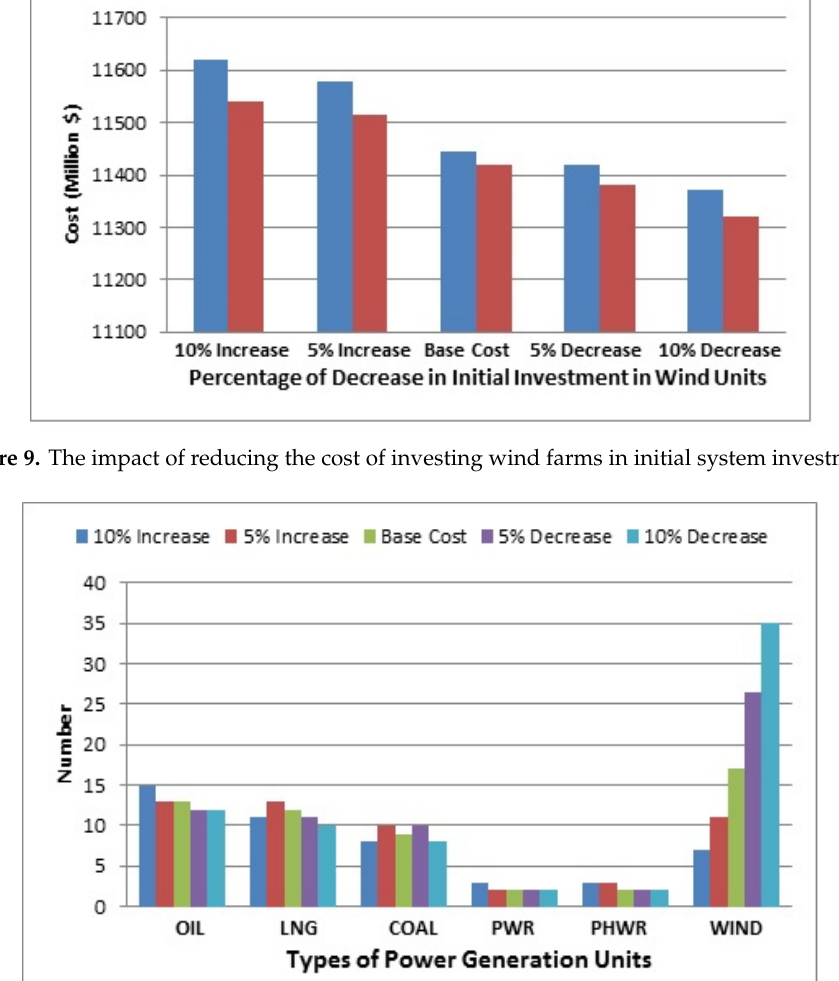
Figure 10. Change in the number of optimal design units by changing the cost of investing in regime 2 wind farms.